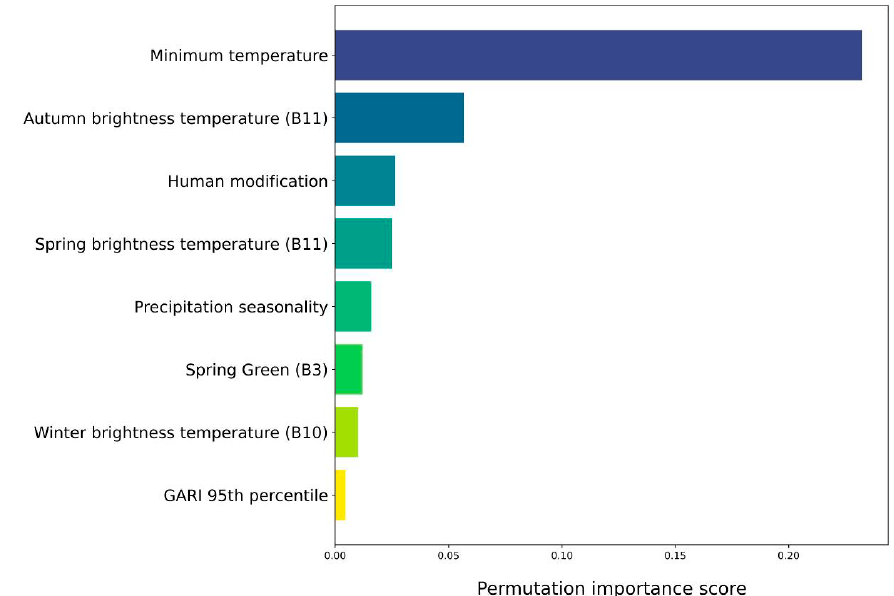
Figure 9. Mean permutation scores for the top eight most important variables used to map and discriminate water hyacinth from other aquatic vegetation from 2013–2015, across 98 reference sites. The permutation importance scores are calculated from the spatially constrained repeated stratified k-fold cross-validation. Note, Shuttle Radar Topography Mission (SRTM) elevation showed similar importance scores to minimum temperature, but was removed owing to its high ( > 0.8) correlation with minimum temperature.